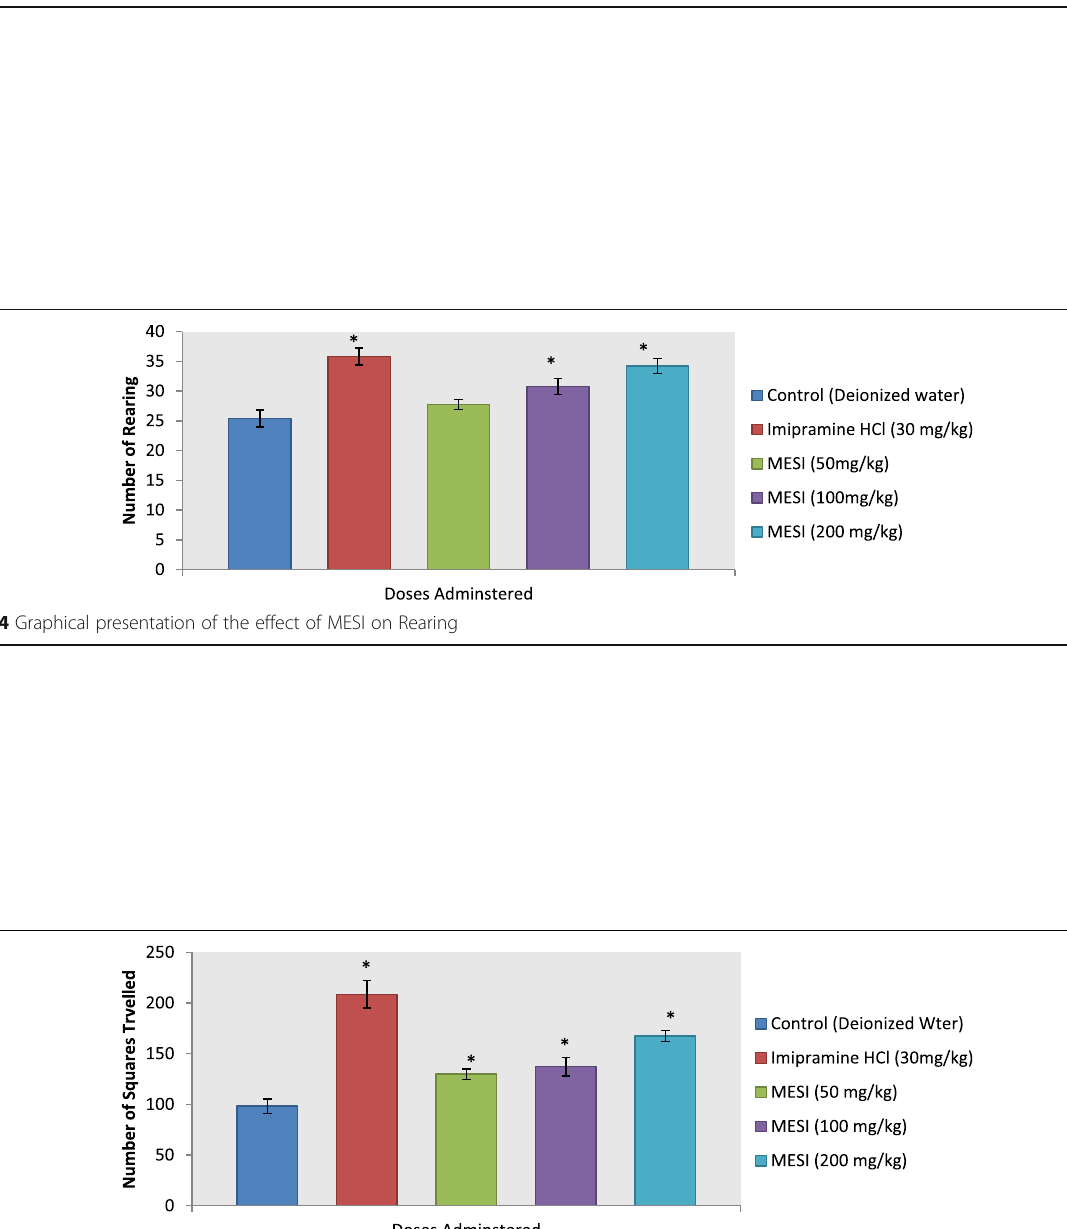
Fig. 3 Graphical presentation of the effect of MESI on Defecation